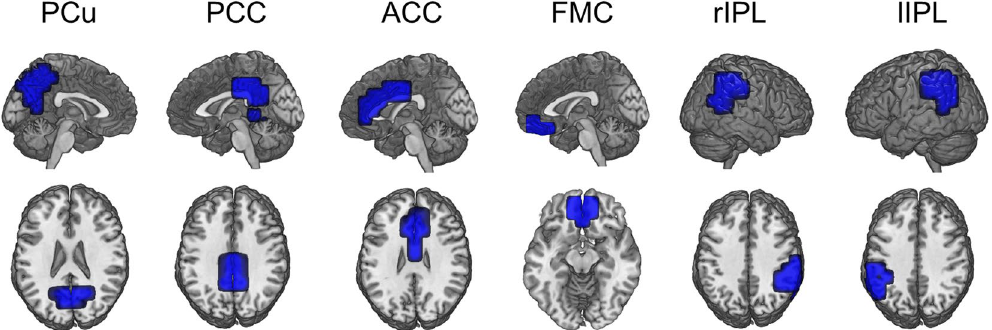
Figure 1. Shapes for the six ROIs related to the default mode network (DMN). The medial parts of the brain (each of the bilateral PCu, PCC, ACC and FMC) were merged into a single ROI. In addition, the right or left supramarginal and angular cortices were merged as rIPL or lIPL. PCu: precuneus, PCC: posterior cingulate cortex, ACC: anterior cingulate cortex, FMC: frontal medial cortex, rIPL: right inferior parietal lobule, lIPL: left inferior parietal lobule.